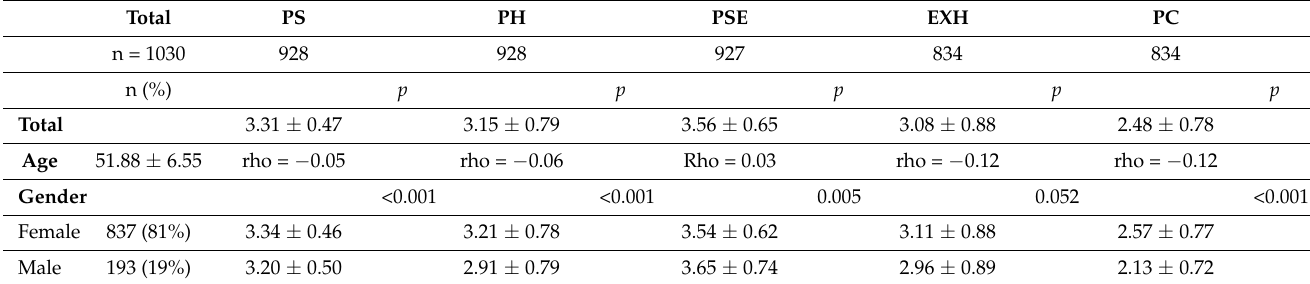
Table 5. Sample size concerning gender, age, and descriptive statistics bivariate analyses of all dependent and independent